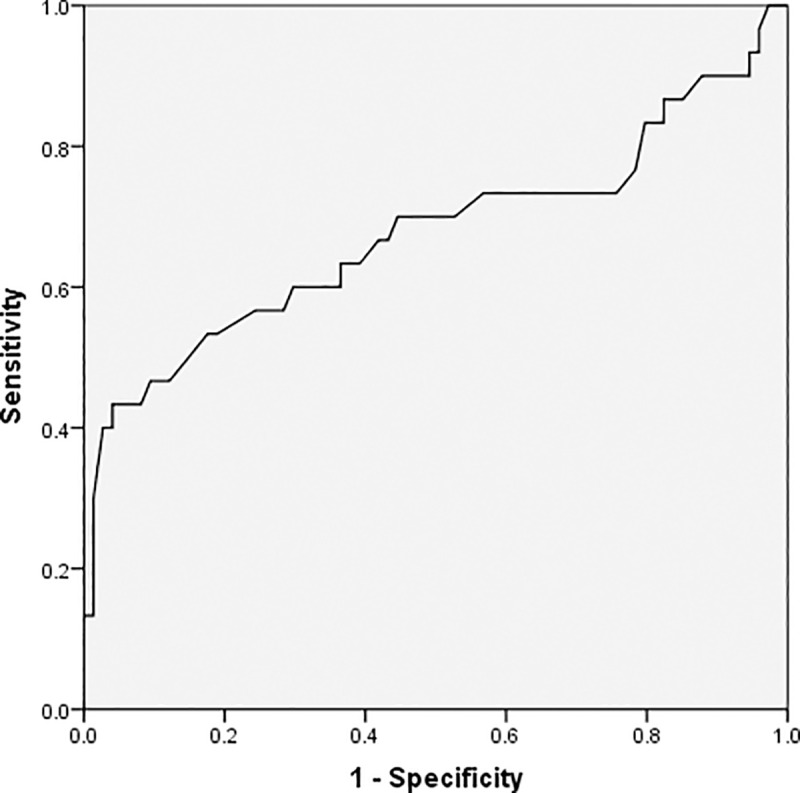
Receiver operating characteristic curve for age.